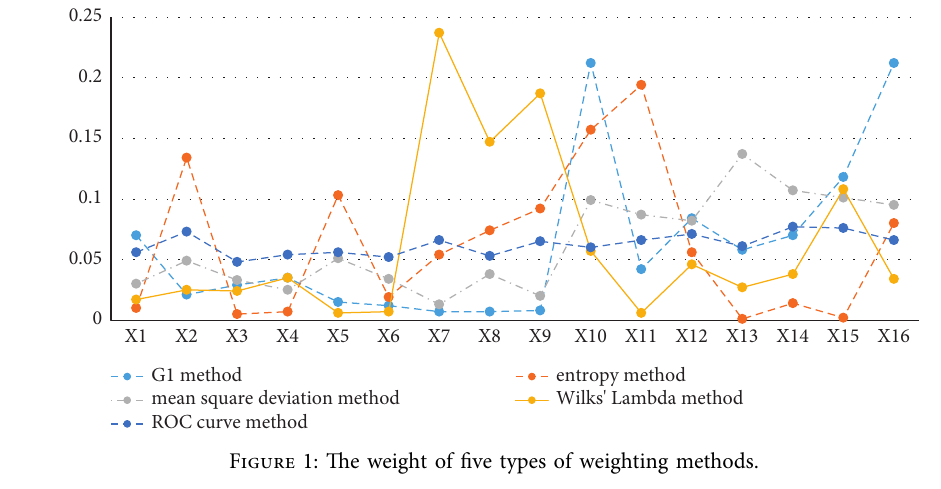
Figure 1: The weight of five types of weighting